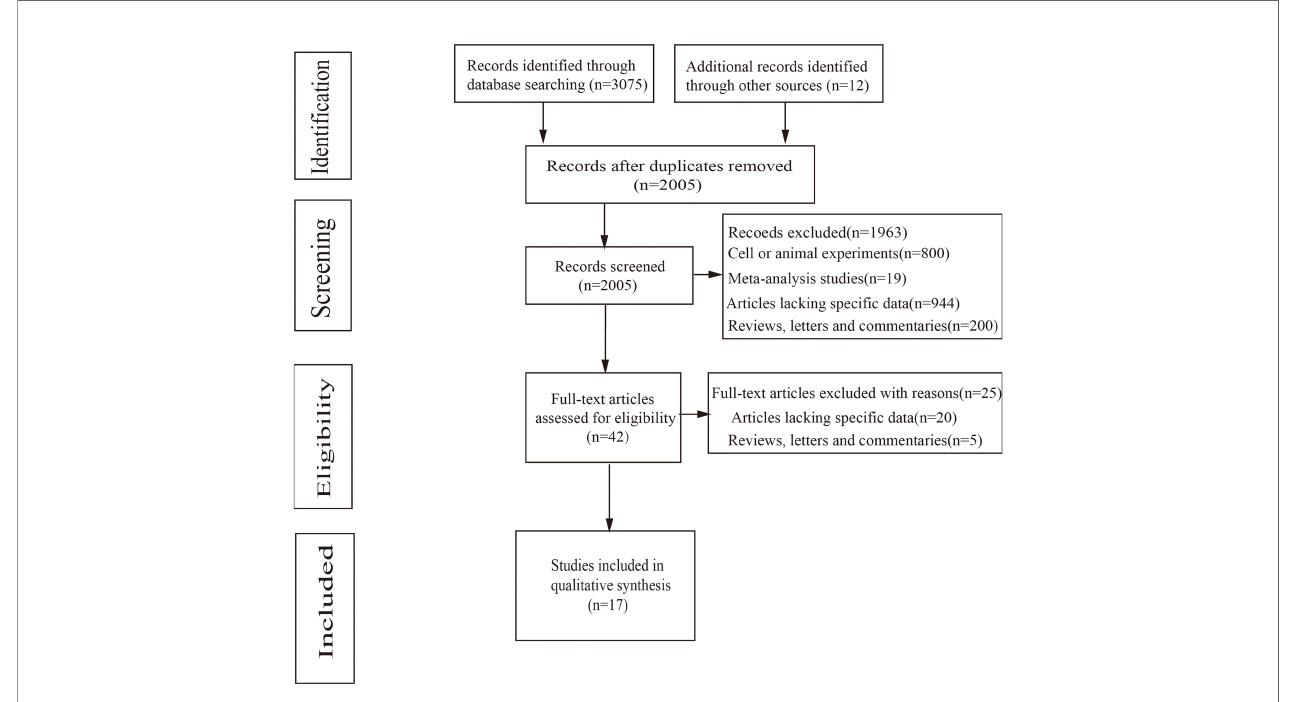
FIGURE 1 | Flowchart for identi fi cation of